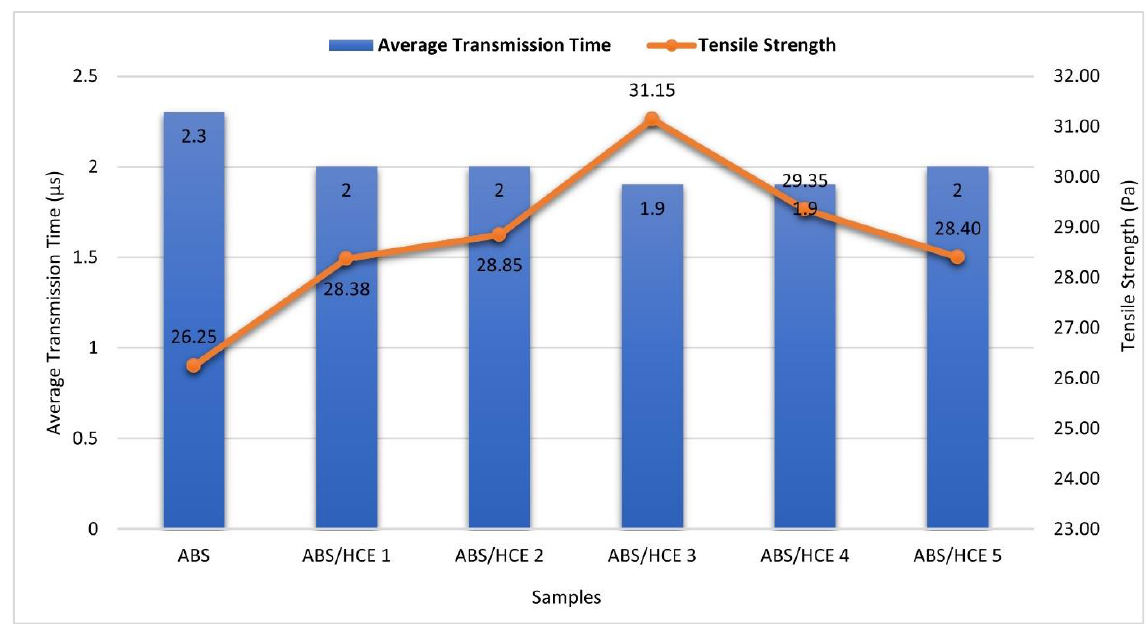
Figure 11. Comparative tensile test results for ABS/HCE composites: ( a ) results from tensile testing with standard deviation as error bars; ( b ) stress-strain curve.